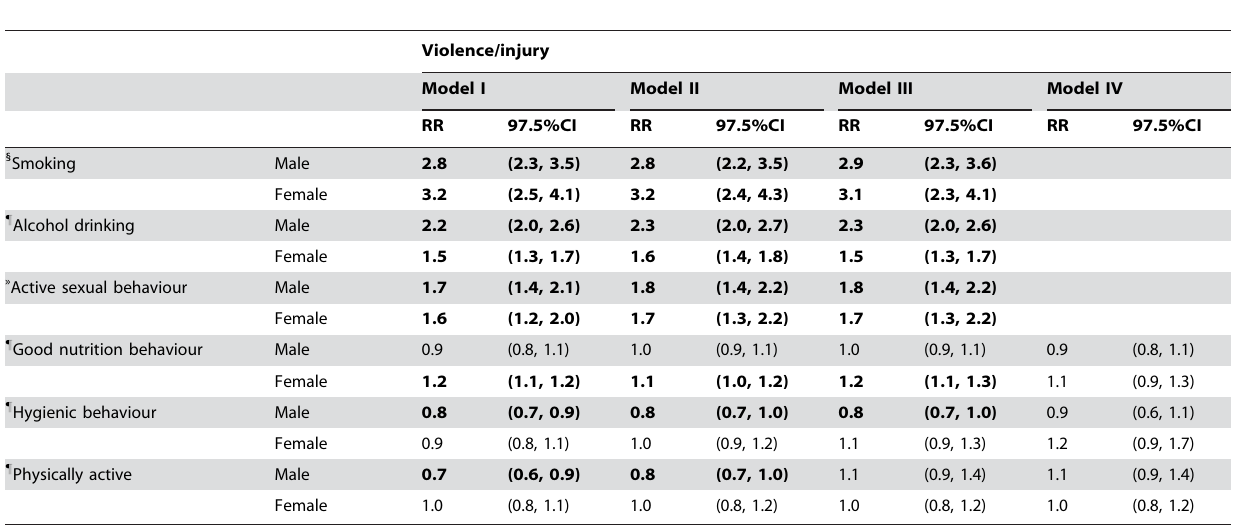
Table 3. Results of multivariate logistic regression analyses for the association of risk and healthy lifestyle behaviours to violence/ injury among adolescents aged 13–15 years old in 9